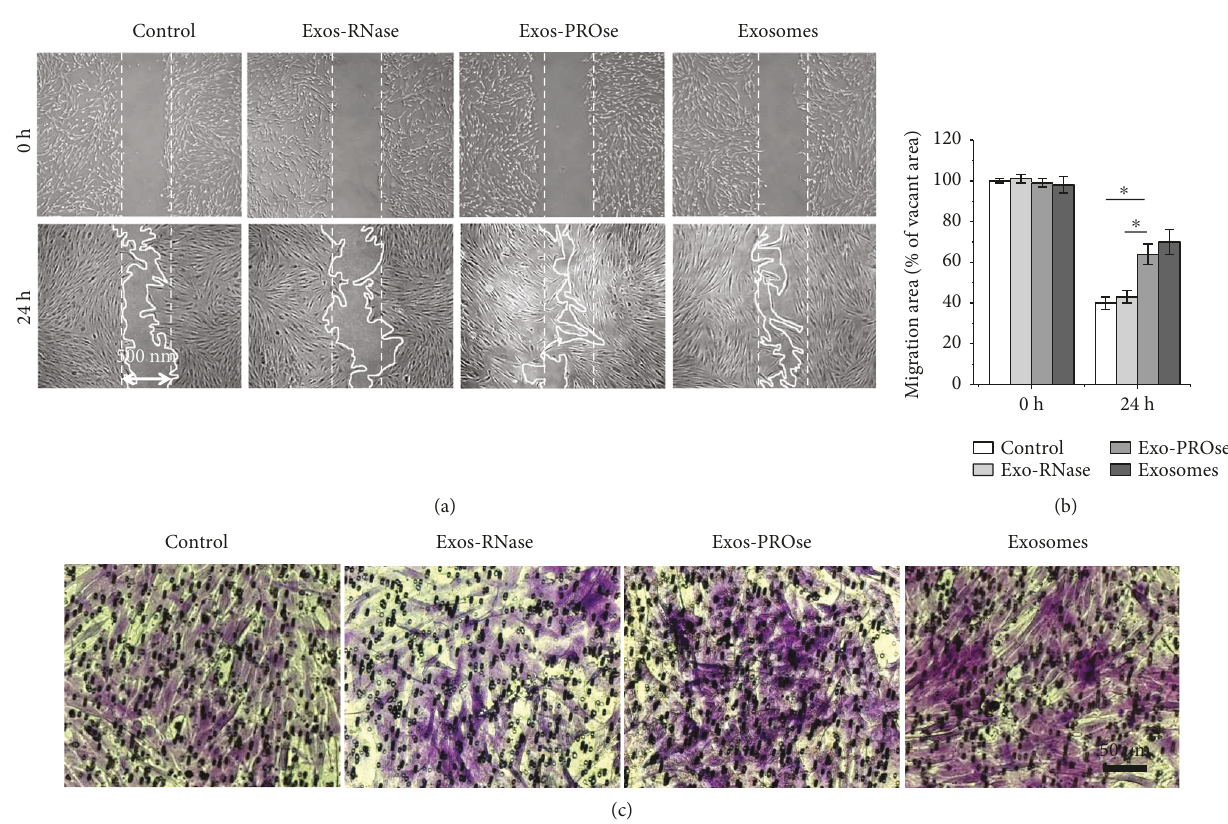
Figure 4: E ff ects of hAEC-Exos on the migration of fi broblasts. (a) Representative images of the scratch wound assay treated by hAEC-Exos at di ff erent time points. (b) Quantitative analysis of fi broblast migration. (c) Microscopic view of migrated cells after crystal violet staining. Scale bar =50 μ m ( ∗ P < 0 05 , n = 3